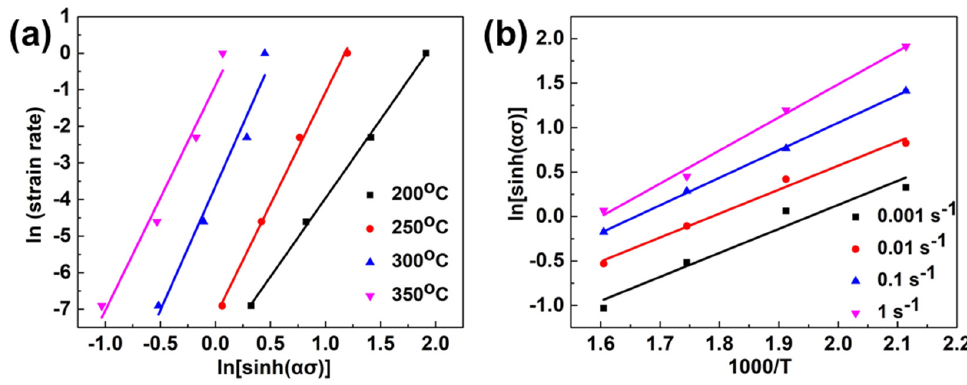
Figure 4. Relationship between peak stress and strain rate, deformation temperature: ( a ) ln ε − ln [ sinh ( ασ P )] and ( b ) ln [ sinh ( ασ P )] − 1000/T. The values of Z at the different deformation temperatures and strain rate can be calculated after the deformation activation energy Q obtained by Equation (1). From Equations (1) and (5), the following relation is obtained: